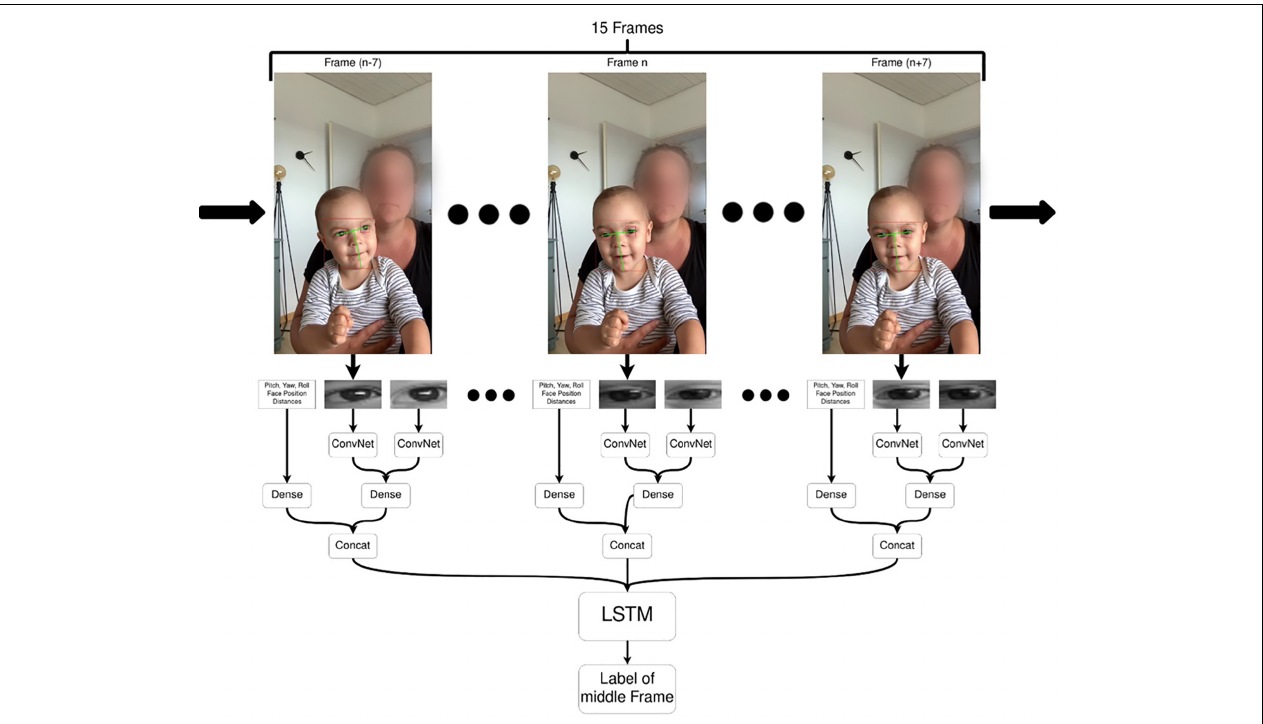
FIGURE 3 | Overview of the automatic coding